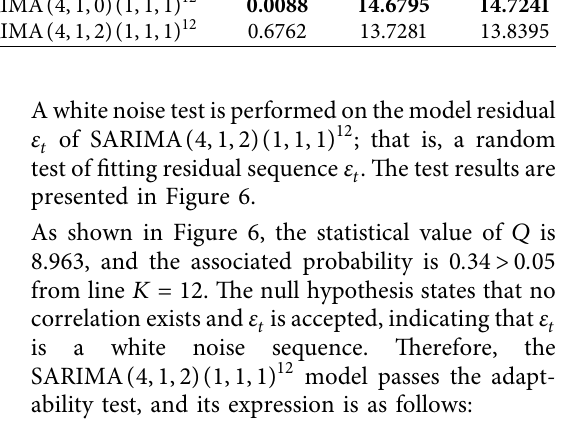
Figure 3: Autocorrelation of sequence dx